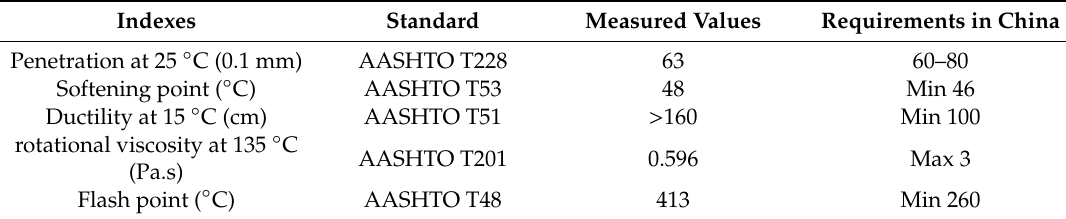
Table 2. Basic properties of asphalt binder